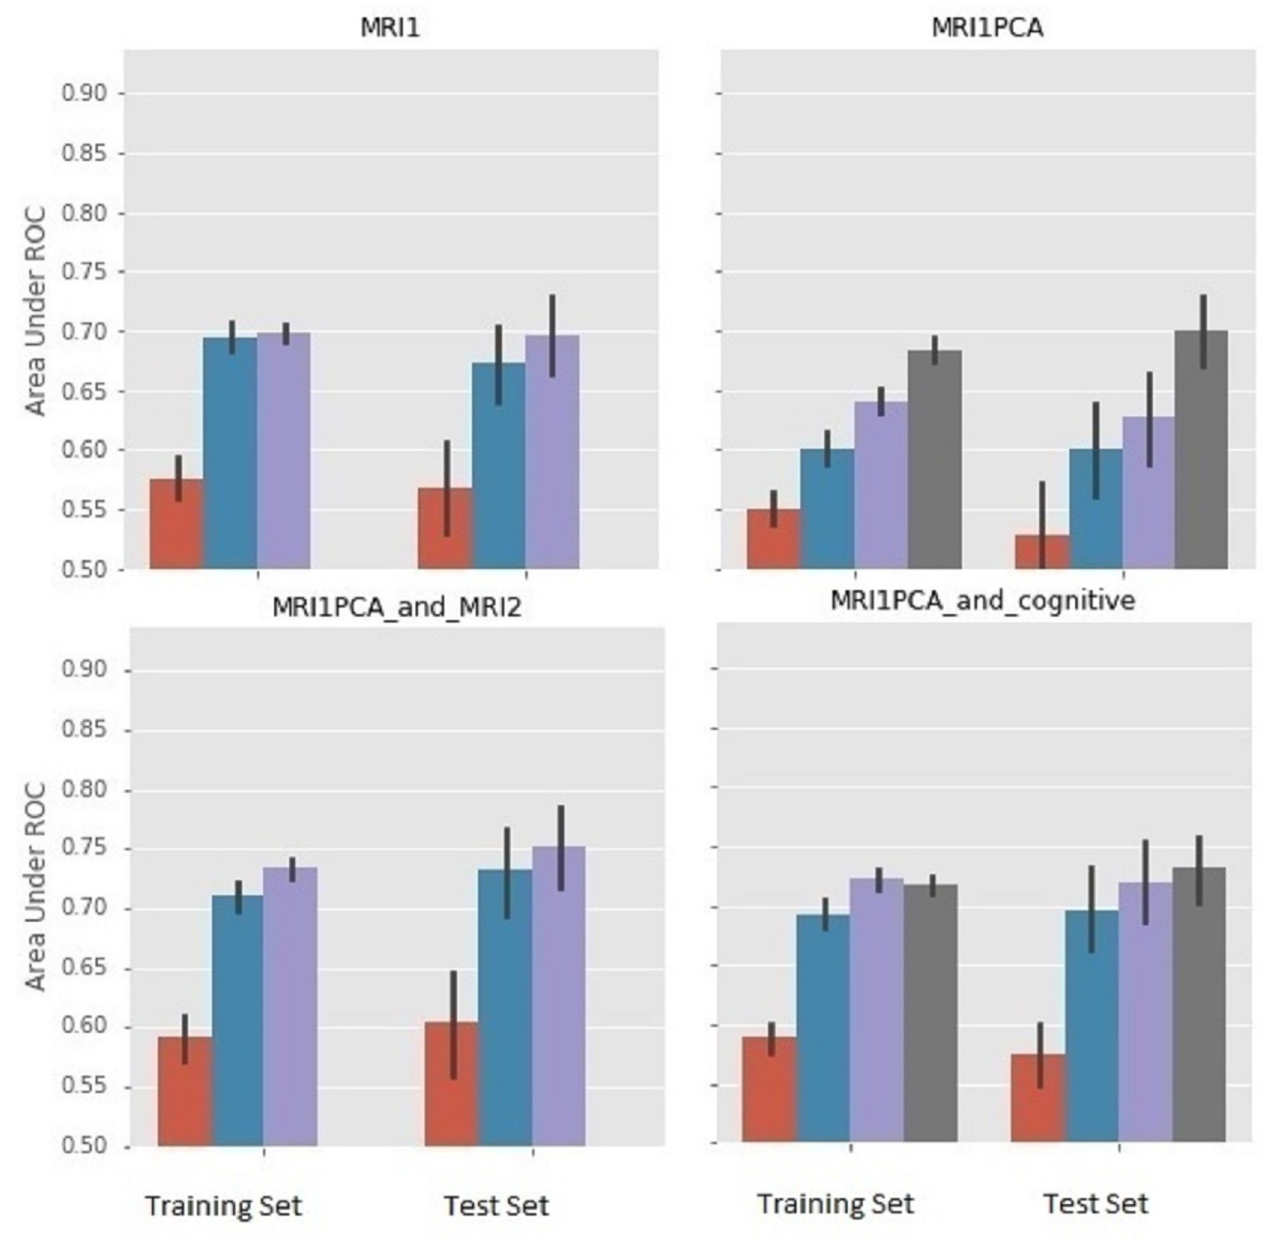
Fig 2. Comparison of different MRI representations & combining baseline MRI data with cognitive or MRI atrophy data. Color coding for bars: red– CART, blue–gradient boost, GB; purple—random forest, RF; dark gray–support vector machine, SVM. For each plot, bars on the left represent performance using leave-two-out cross-validation on the training set, whereas bars on the right represent performance using an independent 45 person test set. The test set was never seen in training and was randomly selected in that it was the complement to the randomly selected training set. We interpreted results from the test